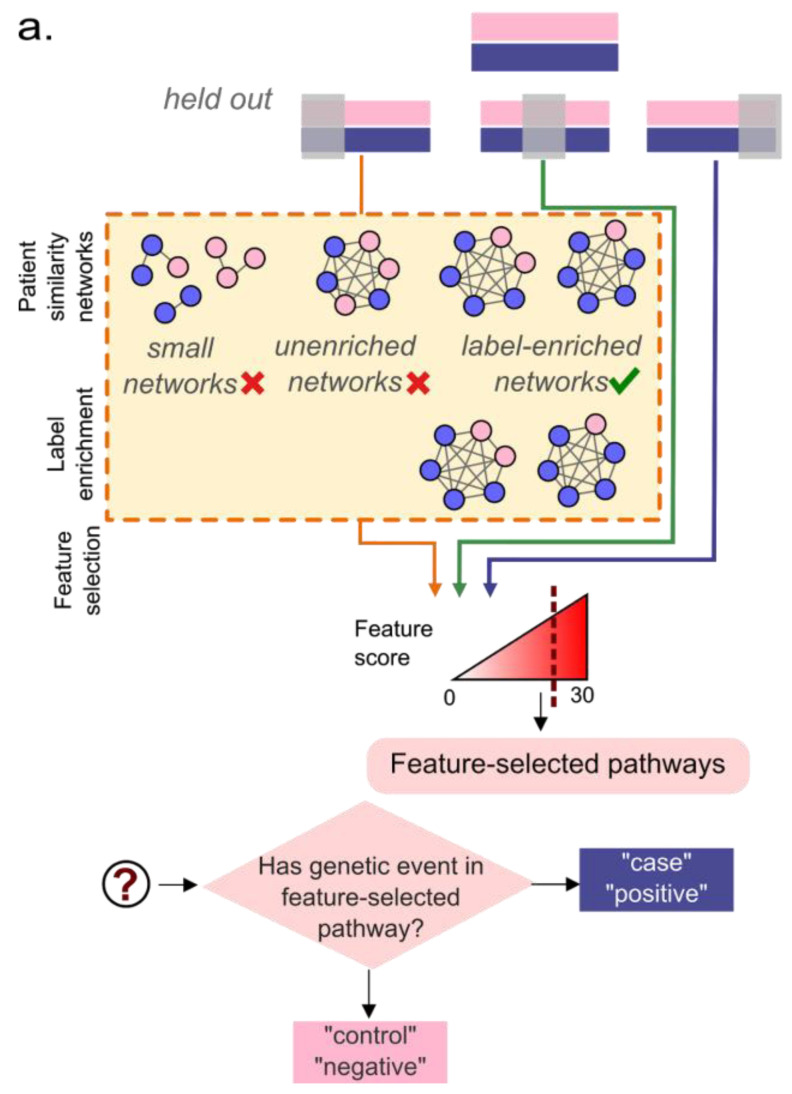
Predictor design for binary classification of case/control diagnosis in netDx, starting from rare CNVs.CNVs are grouped into pathway-level features and patient similarity is binary; i.e. two patients have similarity of one if they share CNVs in genes from the same pathway. Feature selection is iteratively performed on independent thirds of the sample set. This design uses an additional label enrichment step that precedes feature selection. Label enrichment filters out networks with insufficient bias towards case-case edges, using a label-based permutation approach. Networks with significant label enrichment are used in feature selection. Scores from all three feature-selection splits are added to get a final score for each feature, with a maximum attainable score of 30. Test patients are classified as cases if they carry a CNV in a pathway that passes feature selection.